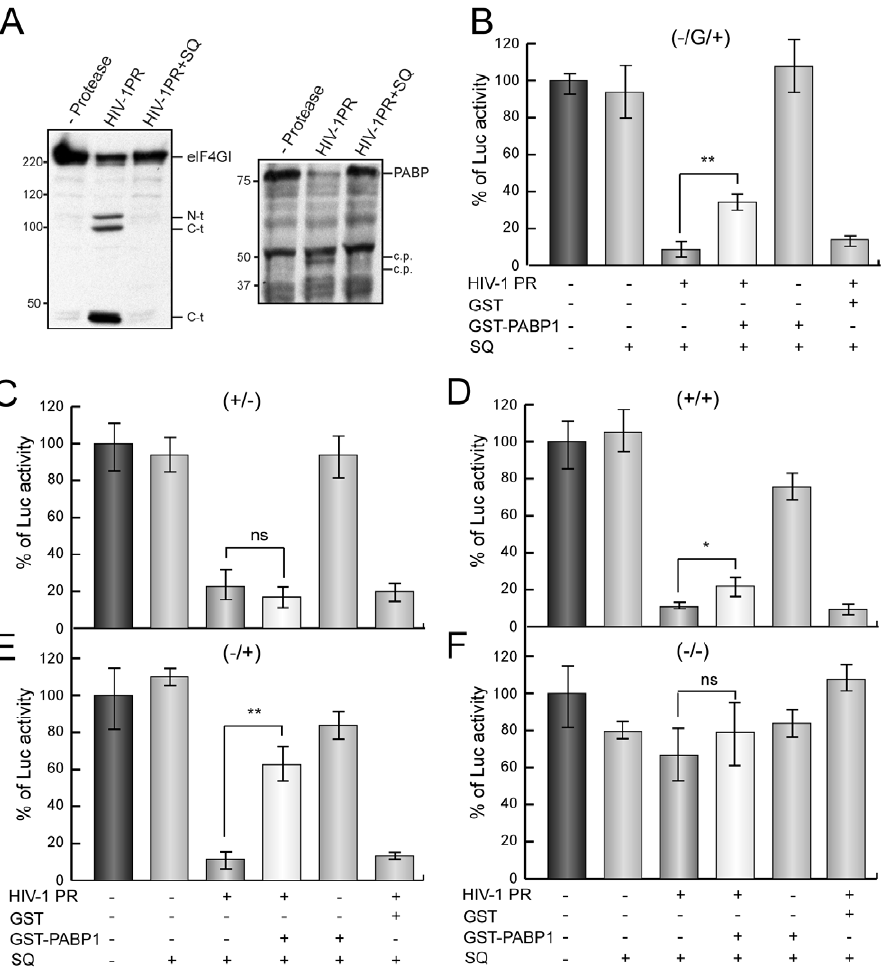
Figure 4. Restoration of poly(A)-dependent translation by addition of recombinant GST-PABP1 in HeLa extracts treated with HIV-1 PR. HeLa lysates were incubated with or without 10 ng HIV-1 PR. The integrity of eIF4GI and PABP was determined by western blotting (A). After 30 min, 20 ng ( 2 /G/ + ) (B), ( + / 2 ) (C), ( + / + ) (D), ( 2 / + ) (E) or ( 2 / 2 ) (F) luc mRNAs and 2.5 m M SQ was added to the extract. In a control reaction, SQ was present throughout the time course (bar 2). The extracts indicated were then supplemented with 25 ng GST-PABP1 or GST. Luc activity was measured 1 h later. The relative Luc activity obtained from ( 2 /G/ + ) (B), ( + / 2 ) (C), ( + / + ) (D), ( 2 / + ) (E) or ( 2 / 2 ) (F) luc mRNAs was represented. *P , 0.05; **P , 0.01; ns, non-significant; C.p., putative cleavage